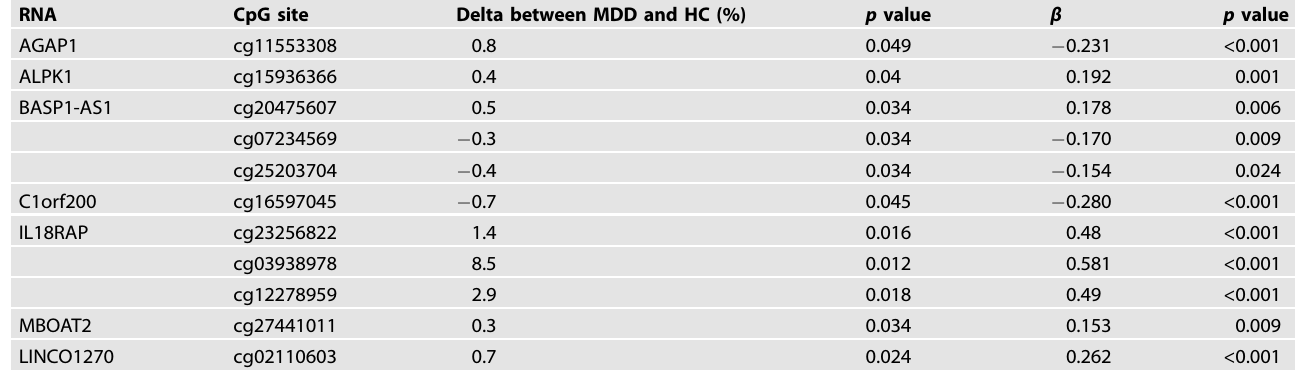
Table 2. Differential methylation between MDD and HC groups for genes displaying differential expression and an association between RNA expression and